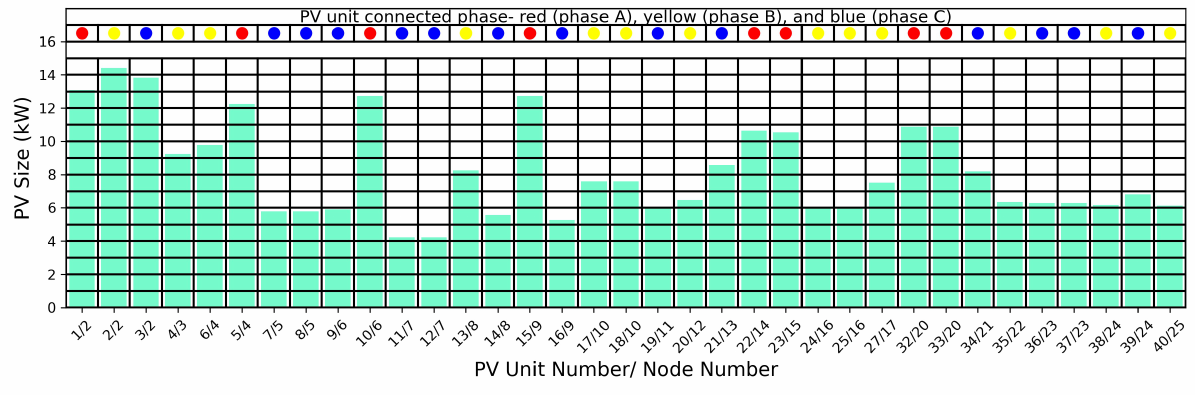
Figure 11. Optimized PV values with the DLR as the thermal limit of the conductors and OLTC voltage regulation.